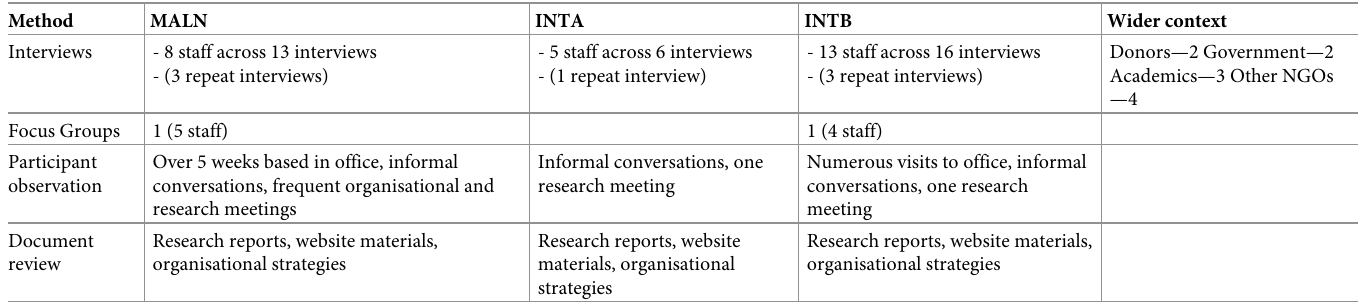
Table 2. Summary of